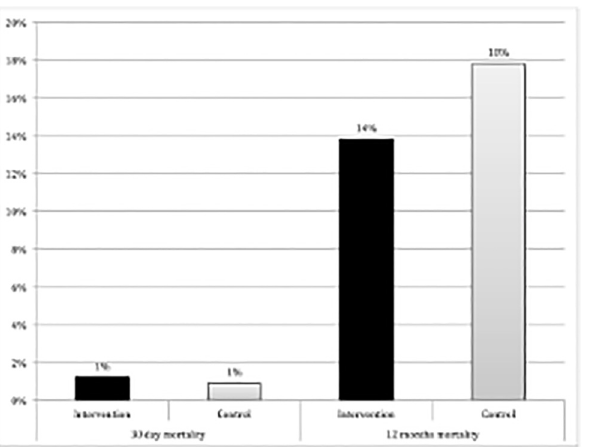
Fig 6. Mortality within 30 days and within one year after surgery for intervention and control groups (p = 0.75 and p = 0.19 respectively). Within 30 days after surgery, 4 patients in the intervention and 3 patients in the control group had died (p = 0.75). One year after surgery, 45 patients in the intervention group compared to 58 patients in the control group had died (p =